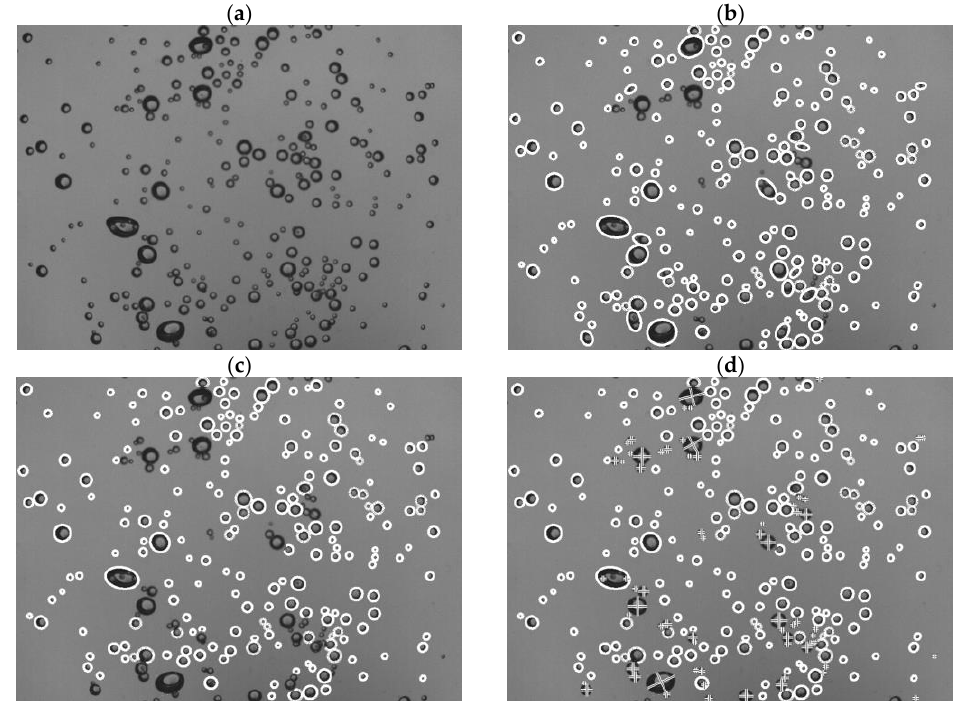
Figure 2. Diagrams of the MBSA deflectors: ( a ) original design; ( b ) new design.